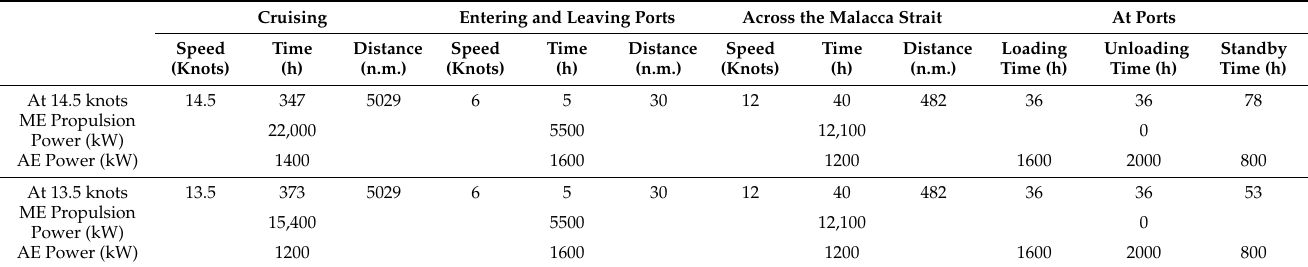
Table 3. Data on the navigation conditions.